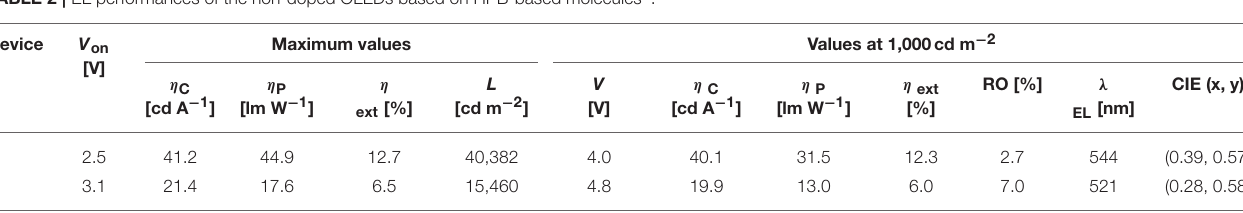
TABLE 2 | EL performances of the non-doped OLEDs based on HPB-based molecules a .